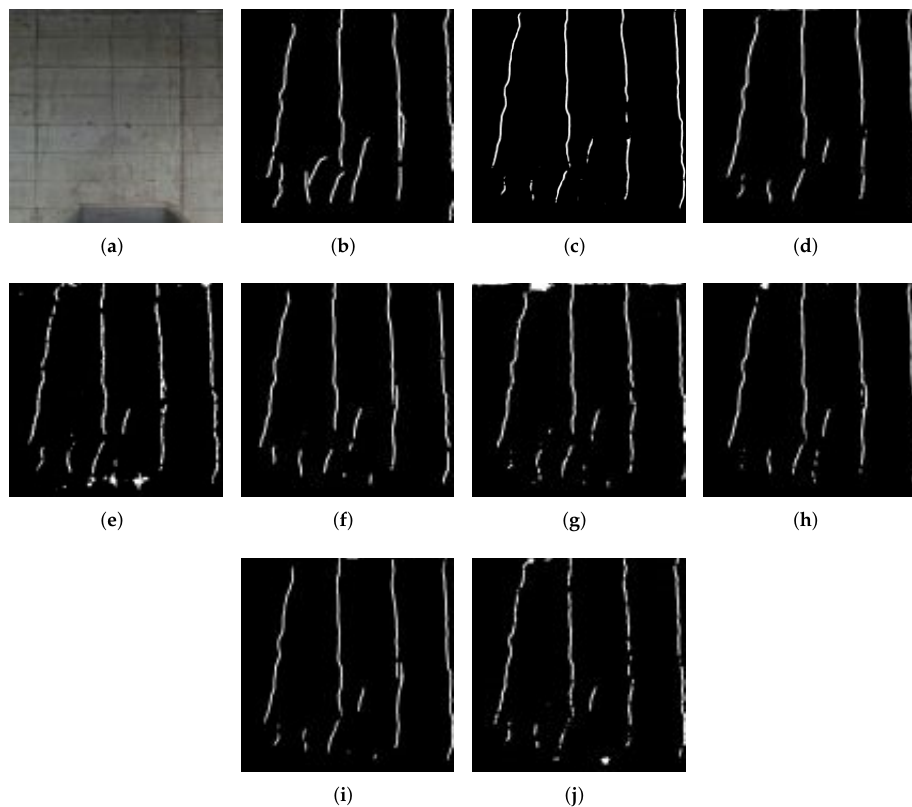
Figure 8. Example of the result for crack detection. ( a ) Original image. ( b ) Ground truth. ( c ) PM. ( d ) CM1. ( e ) CM2. ( f ) CM3. ( g ) CM4. ( h ) CM5. ( i ) CM6. ( j )